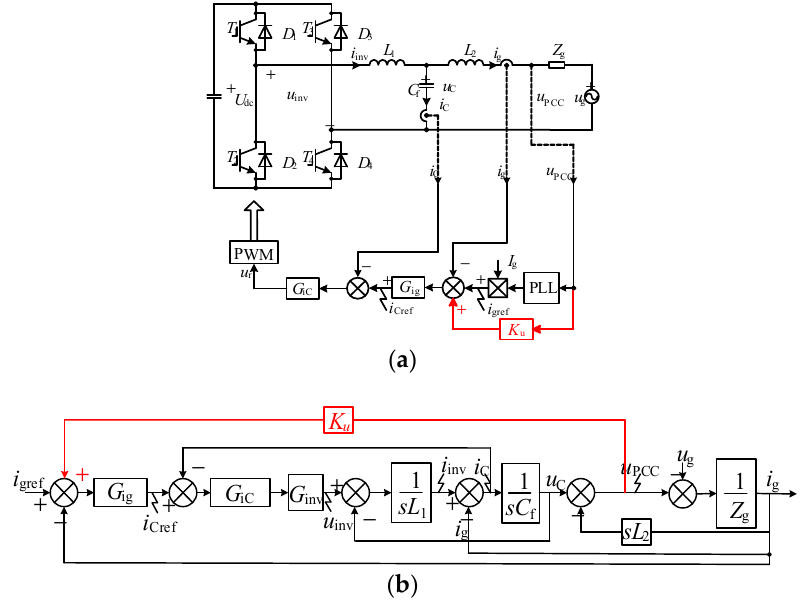
Figure 8. LCL-type grid-tied inverter for single-phase: ( a ) the main circuit structure with grid voltage